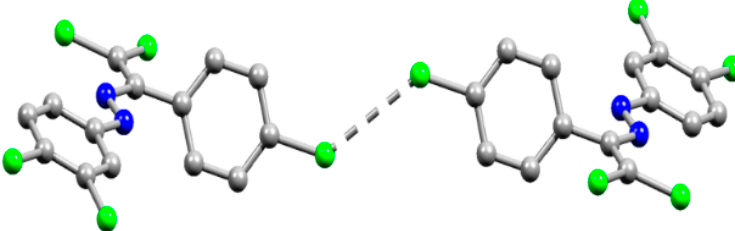
Figure 3. Ball-and-stick representation of 17 and its supramolecular dimerization via Cl···Cl type 1 bonding in the crystal. Blue, green, and grey spheres represent nitrogen, chlorine, and carbon atoms, respectively. Hydrogen atoms were omitted for clarity.